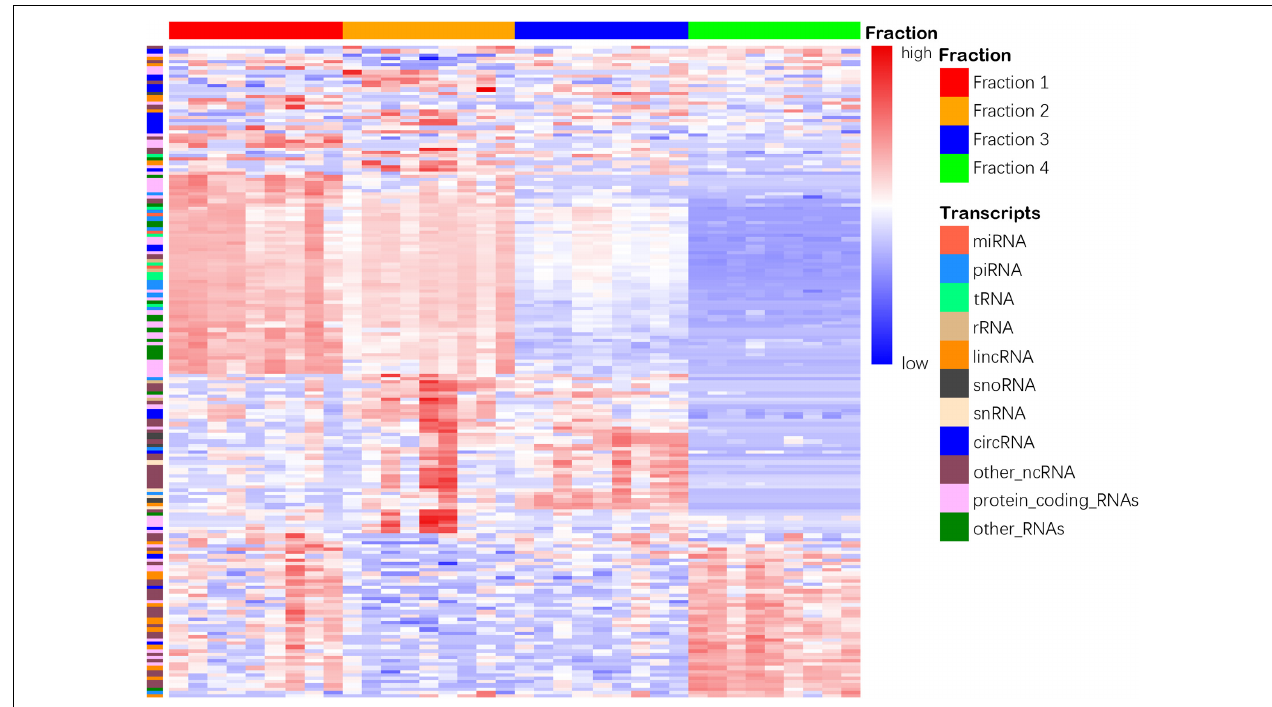
FIGURE 6 | Heatmap shows distinct clustering of 4 plasma fractions. Top horizontal color bars represent 4 different fractions. One hundred eighty-seven differentially enriched transcripts in 11 RNA categories are shown in each row (adjusted p < 0.01). The numbers 1–4 represent fractions for Precipitate 1, Precipitate 2, EV Precipitate and the leftover,